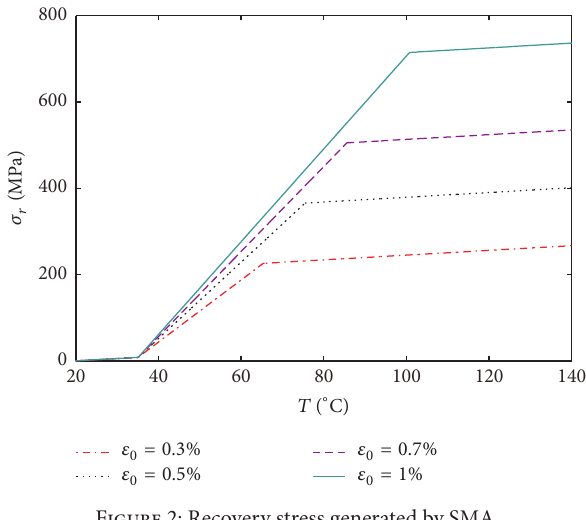
Figure 2: Recovery stress generated by